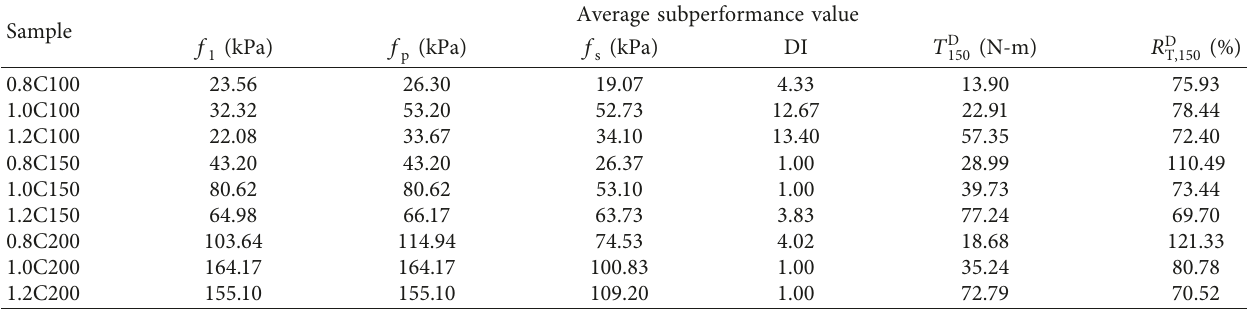
Table 3: Average subperformance values of LFS.